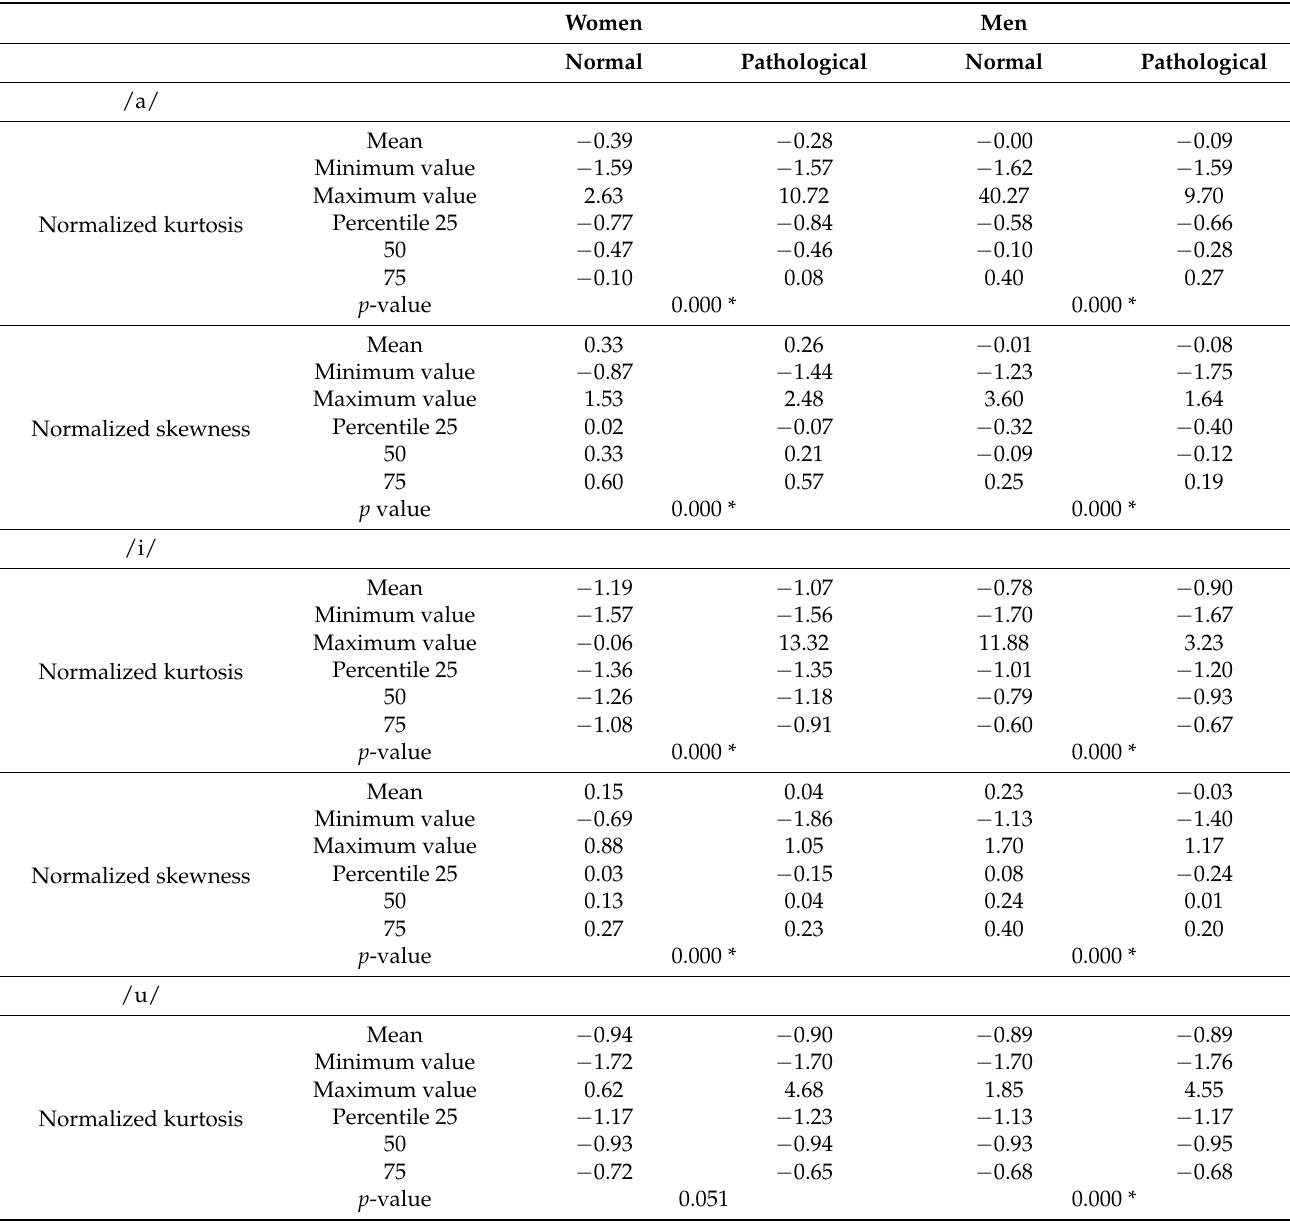
Table 4. HOS values in each vowel between women and